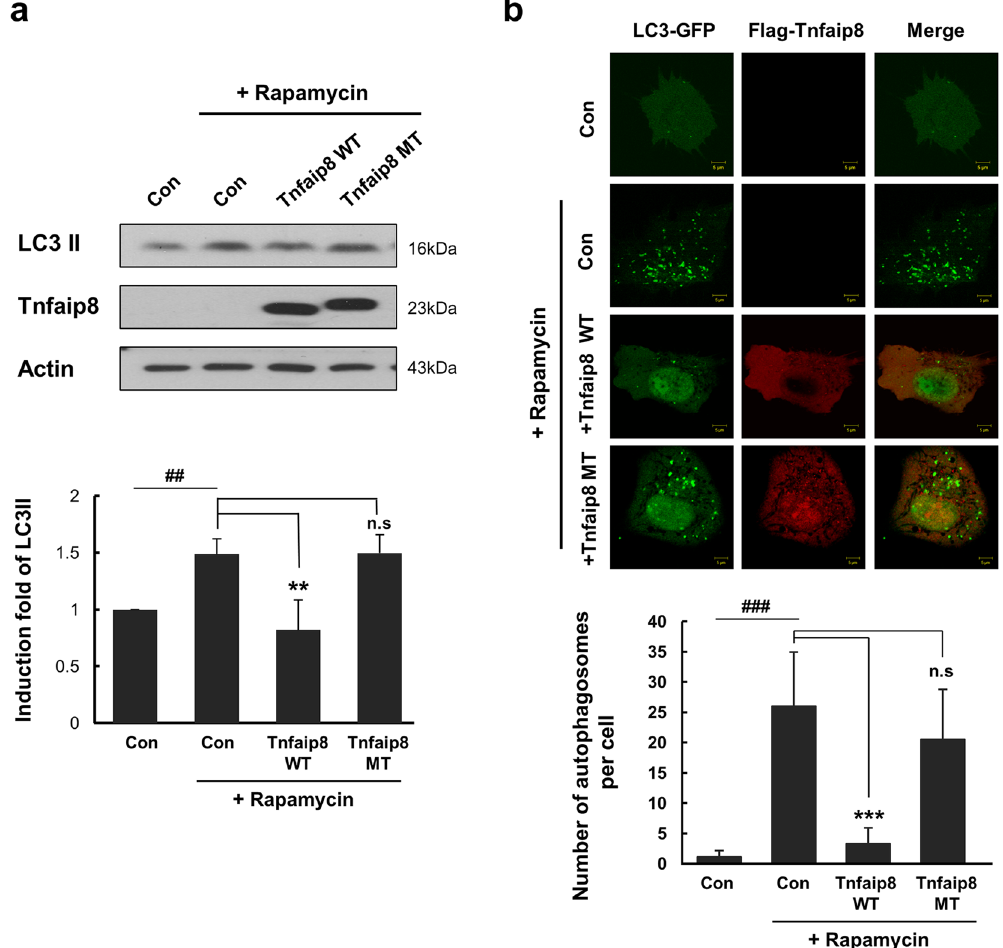
Figure 6. The anti-autophagic action of mTnfaip8. The anti-autophagic activities of mTnfaip8 (WT) and the mTnfaip8 triple mutant (MT) were assessed by analyzing the levels of autophagy marker LC3 II ( a ) and by quantitative confocal image analyses of GFP-LC3 puncta formation ( b ) in Hepa 1-6 cells after induction of autophagy by rapamycin (1 μ M) for 3 h. The triple mutant (MT) dramatically lost inhibitory regulation of rapamycin-induced autophagy, whereas wild type (WT) demonstrated normal autophagic inhibition. Values are means (SD). ## p/ ** p < 0.01 and ### p/ *** p < 0.001. The full-length blots are presented in Supplementary Figure 3 (Fig.